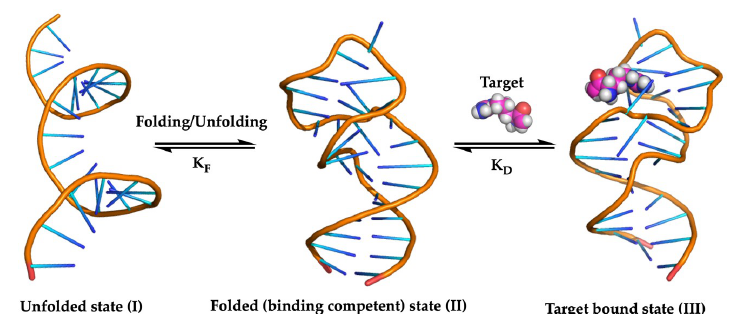
Figure 1. Equilibrium between the unfolded aptamer state ( I ) and its binding competent state ( II ) with corresponding equilibrium constant K F . The binding competent state ( II ) is able to bind the target (conformation III ), which is characterized by the dissociation constant K D .